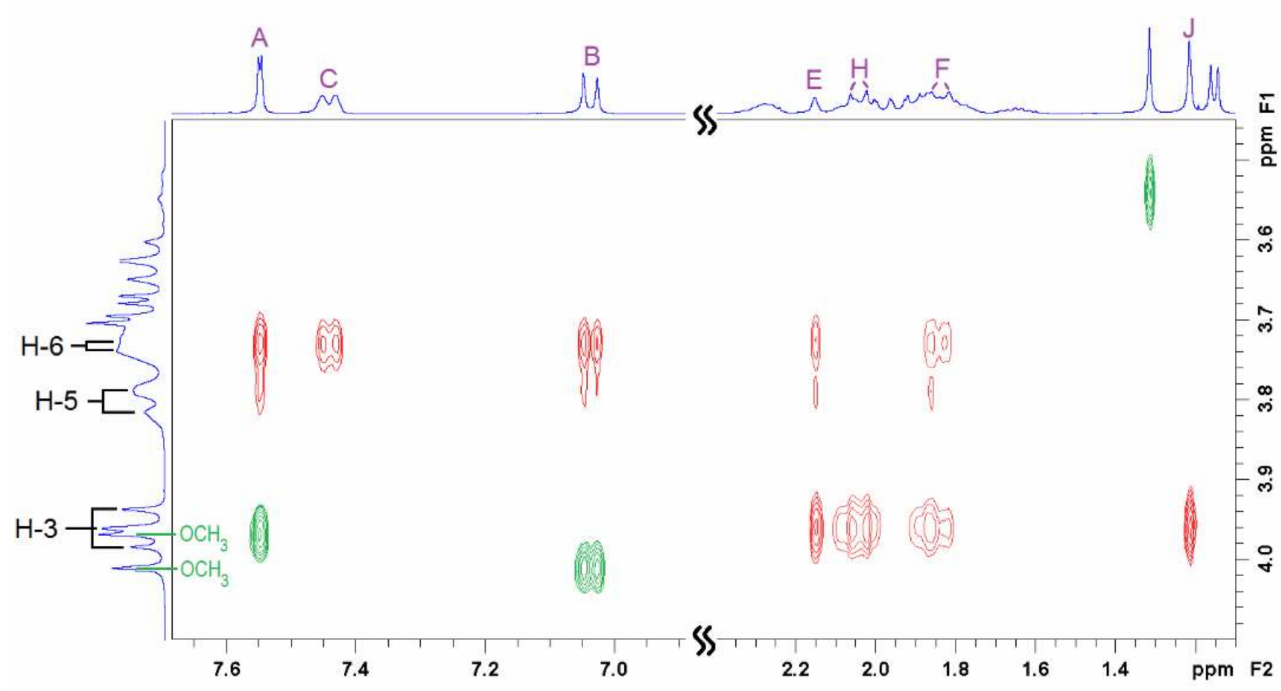
Figure 4. Two-dimensional ROESY NMR spectrum of the 1:1 VTD: β -CD inclusion complex showing intermolecular ( red ) and intramolecular ( green ) cross-peaks. See Figure 1a,c for atom